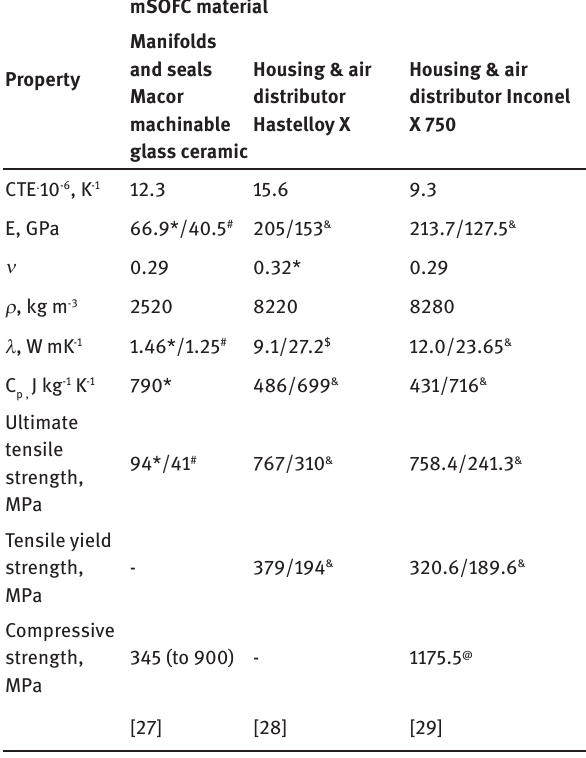
Table 2: Mechanical properties of mSOFC stack materials used in the FEM simulations [27-29].